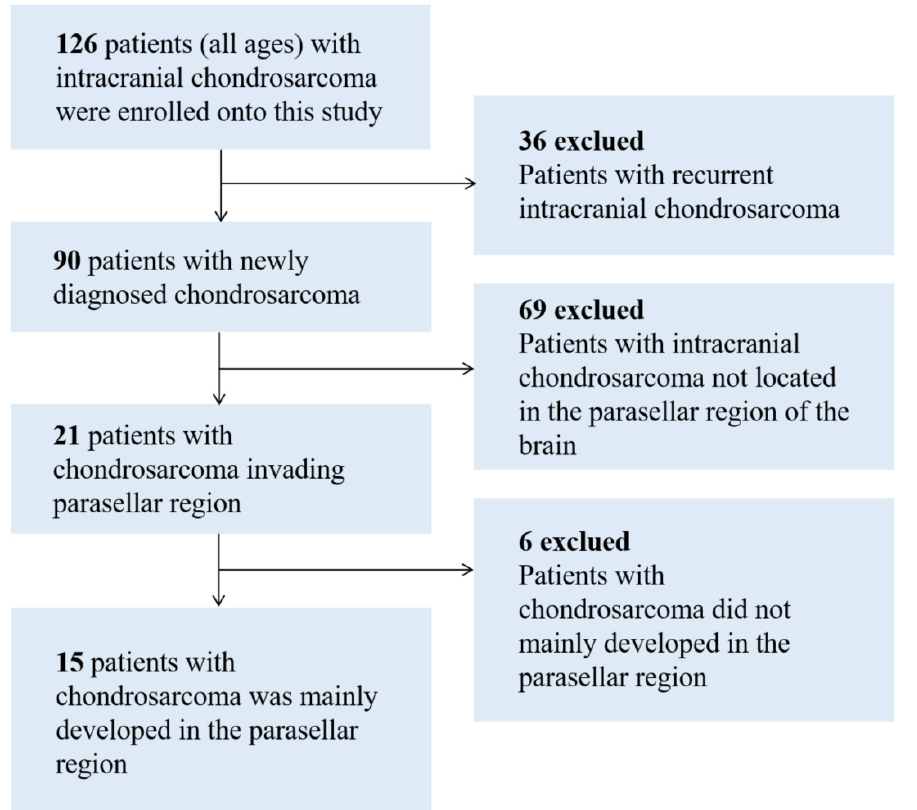
Figure 1. Flow chart of inclusion patients.